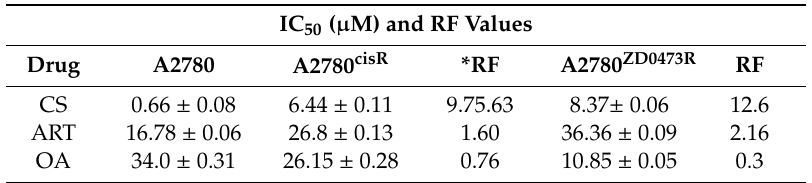
Table 1. IC 50 values of cisplatin (CS), artemisinin (ART), and oleanolic acid (OA) as applied to the human ovarian cancer cell lines, A2780 A2780 cisR , and A2780 ZD0473R cell lines based on, at least, triplicate measurements, with the period of incubation being 72 h.